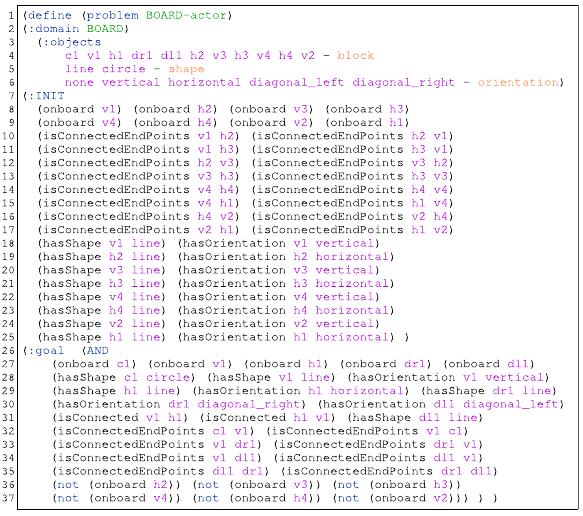
Figure 4 pictures the BOARD-AI main interface.